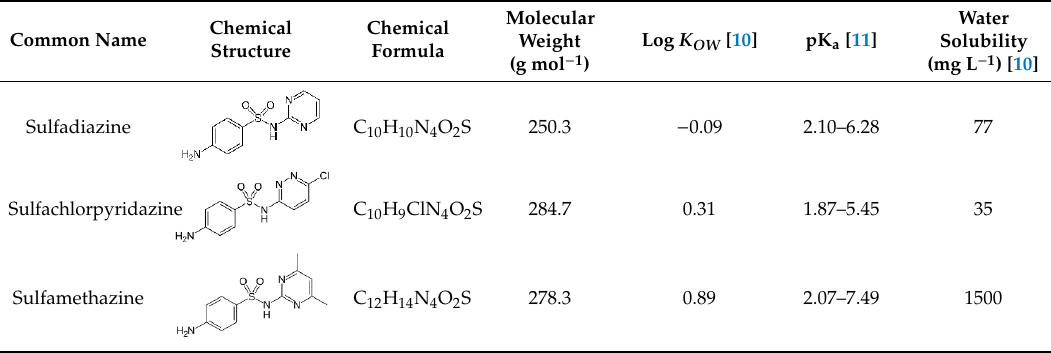
Table 3. Main characteristics of three different sulfonamide antibiotics.